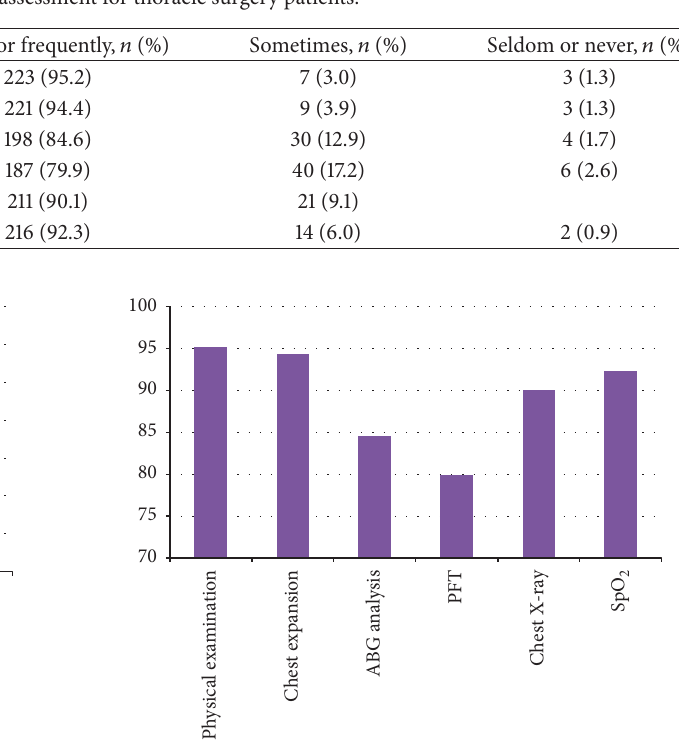
Figure 4: Postoperative assessment for thoracic surgery